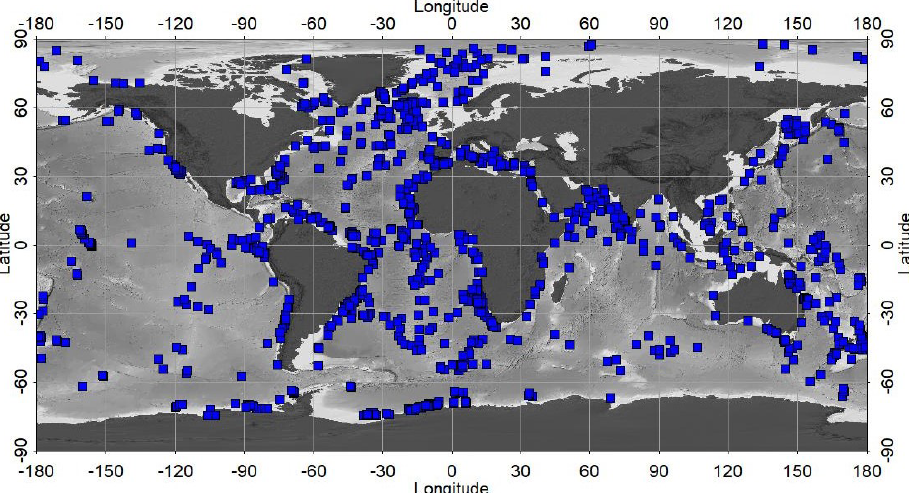
Figure 1. Spatial distribution of stable isotope records available in this atlas. The map has been generated with PaleoDataView (Langner and Mulitza, 2019).